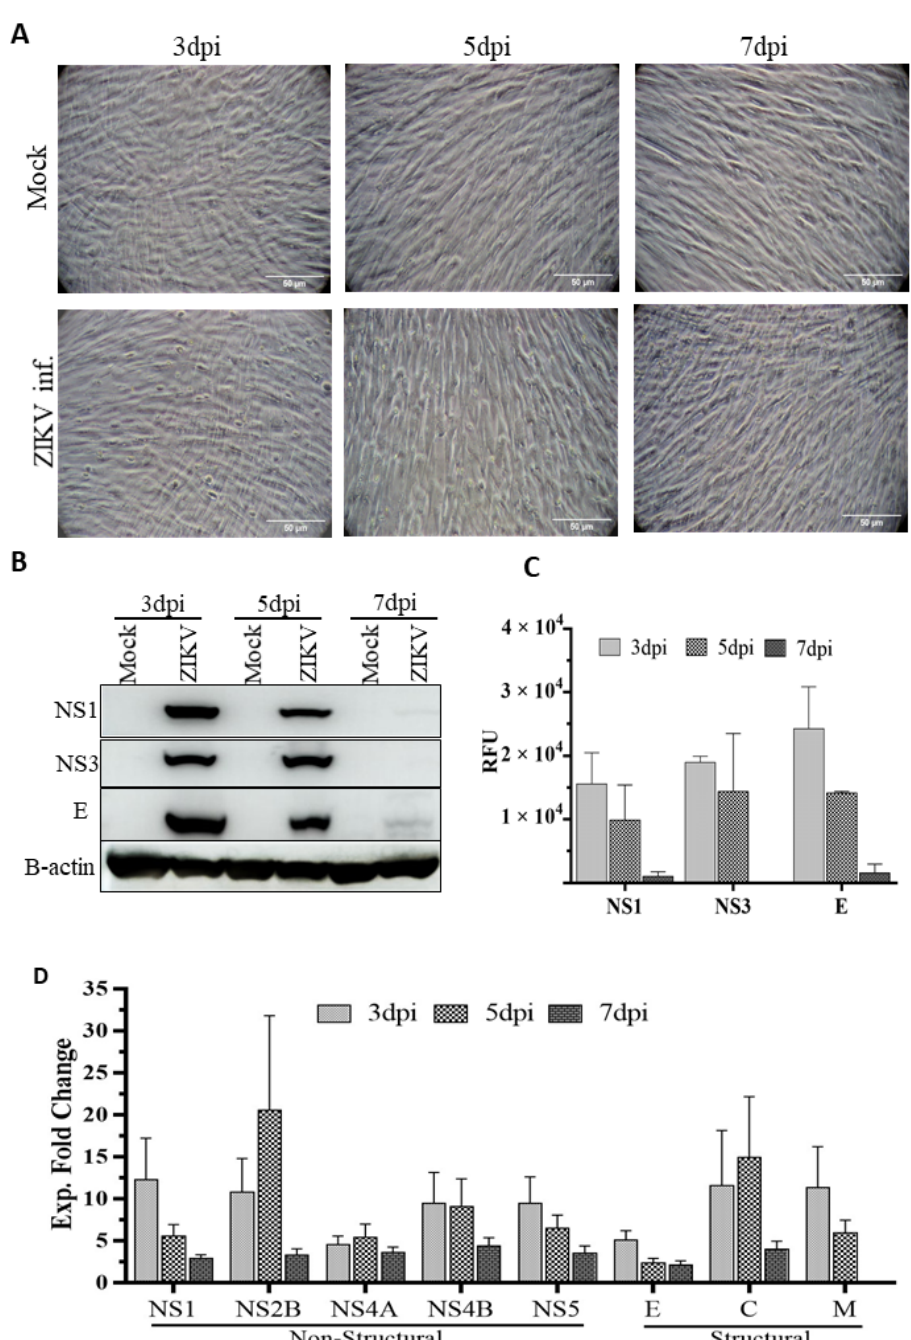
Figure 1. Cytopathic impact of ZIKV infection on HSerC and viral protein expression. HSerC were infected with ZIKV an MOI of 3. ( A ) Cytopathic impact of ZIKV infection was observed at 3, 5 and 7 days post infection (dpi) under bright − field microscopy at 200 × magnification. Scale bar is 50 µ m. ( B ) Viral protein expression was determined by Western blot using ZIKV-NS1, NS3 and ENV monoclonal antibodies at 3, 5 and 7 dpi. ( C ) Quantitative expression of ZIKV viral proteins determined by densitometry analysis of Western blot images using Image J and normalized to B-actin expression. ( D ) ZIKV proteins expression detected after 3, 5 and 7 dpi by mass spectrometry. Log2 expressions of ZIKV proteins were compared with mock-treated cells and converted to Fold Change (FC) Abbreviations. dpi = Days post infection. Exp = Expression. RFU = Relative fluorescence units.